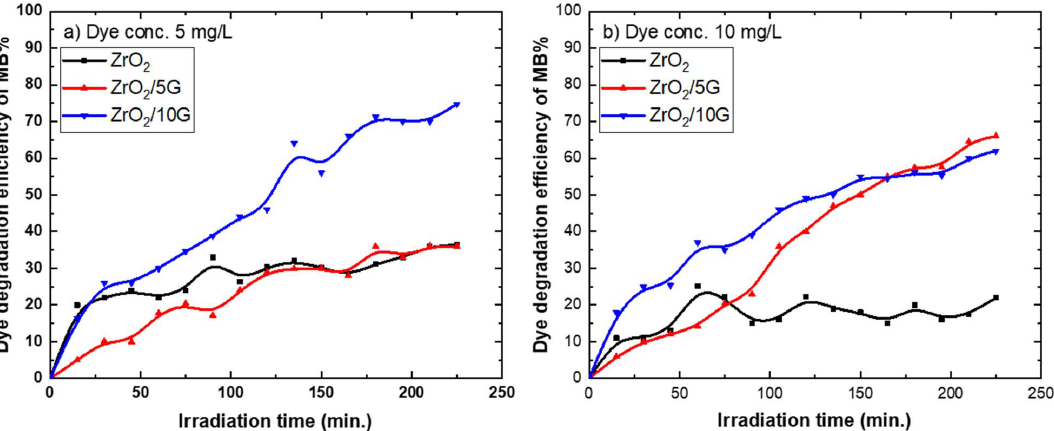
Figure 6. Photocatalytic degradation of methylene blue (MB) on ZrO 2 , ZrO 2 /G5, and ZrO 2 /G10 for both concentrations of MB of: ( a ) 5.0 and ( b ) 10.0 mg/L.